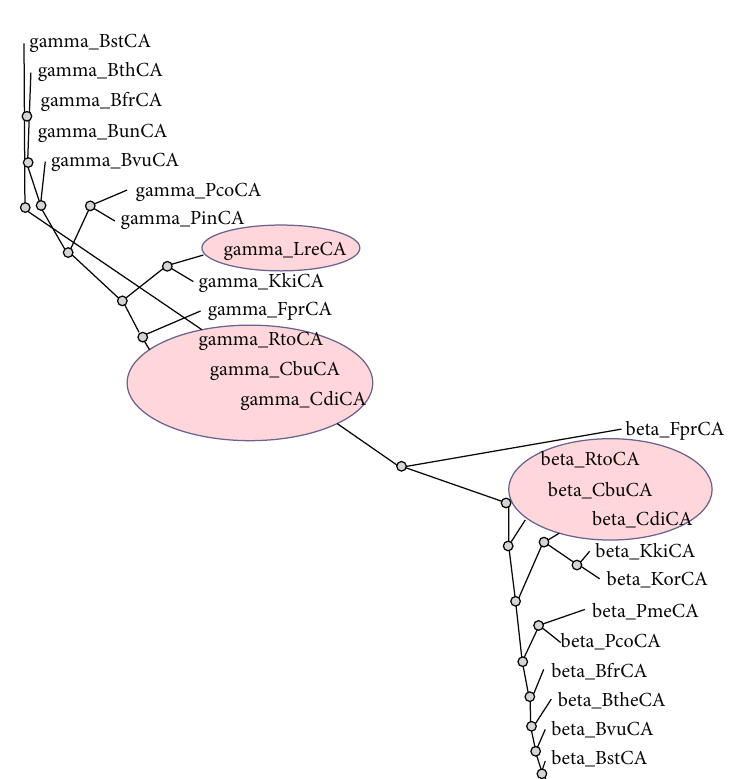
Figure 1: Dendrogram obtained by the phylogenetic analysis carried out on ?- and ?-CAs identi fi ed in the genome of the Gram-negative and Gram-positive bacteria indicated in Table 1. The tree was constructed using the program PhyML 3.0. Accession numbers of the amino acid sequences used in the phylogenetic analysis are given in Table 2. Blue circles indicate the Gram-positive